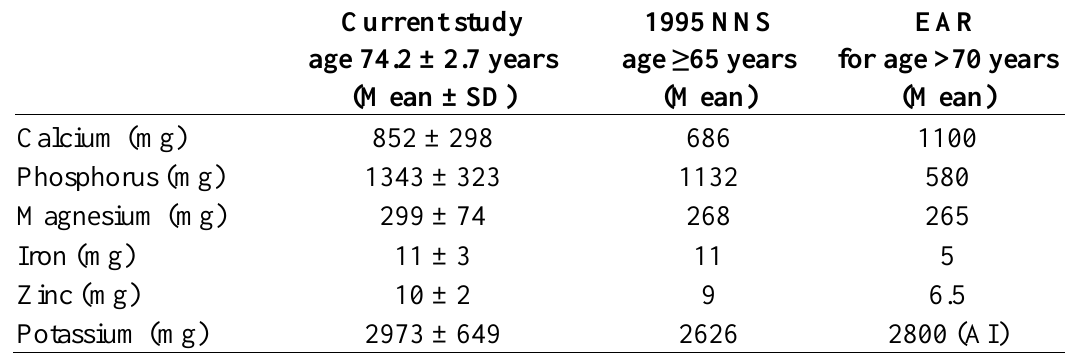
Table 3. Mean dietary mineral intake in the current study (n = 218) compared to the 1995 National Nutritional Survey (NNS) and Australian